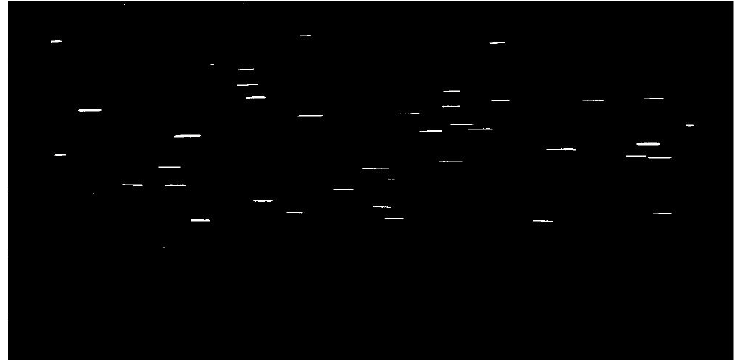
Figure 10. Experiment 1: 150–200 mm from origin of central jet. Exposure time: 100 μ s. Filtered to remove noise but not cropped upstream and downstream. For scale see Figure